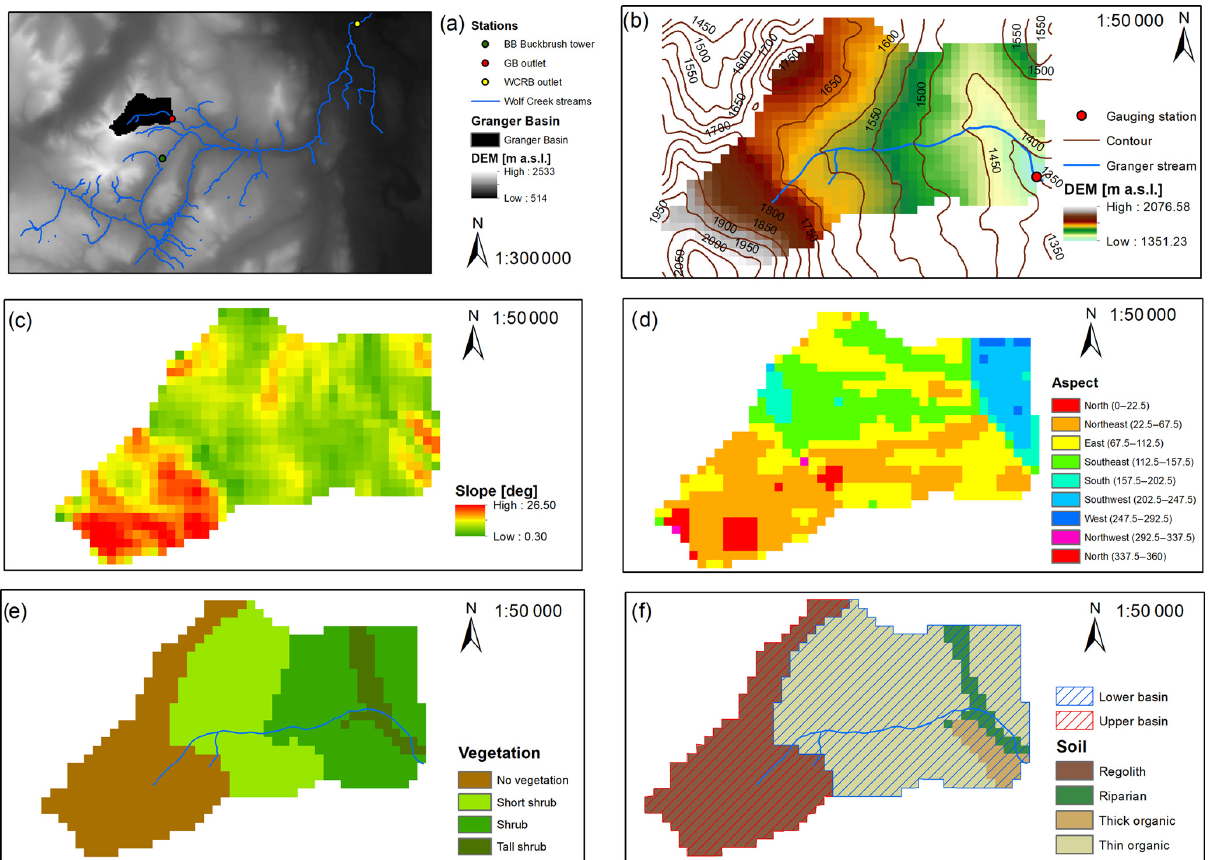
Figure 1. Granger Basin (GB) characteristics showing (a) location within the Wolf Creek Research Basin (WCRB), stream network and gauging station, (b) topography, (c) slope, (d) aspect, (e) vegetation types and (f) soil types. Lower (LB) and upper basin (UB) areas are